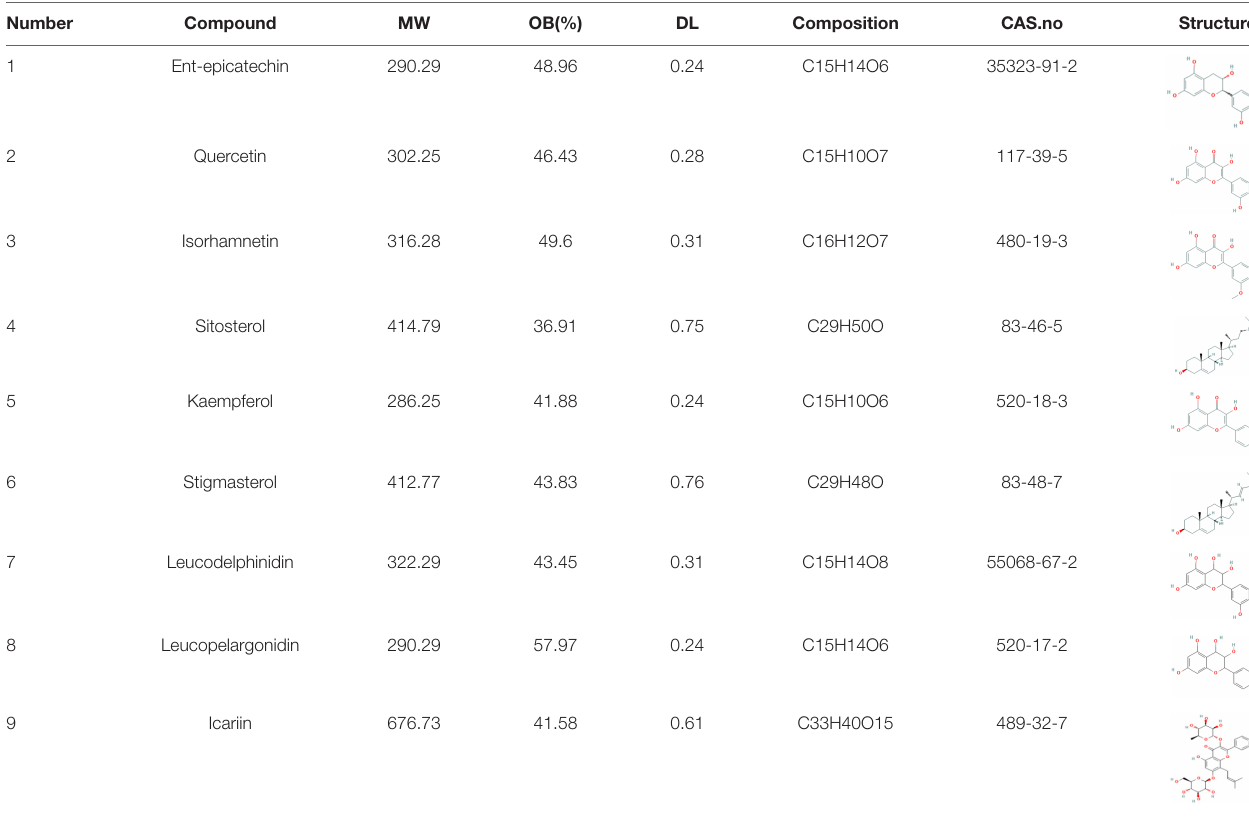
TABLE 1 | Chemical information for the active compounds of hawthorn